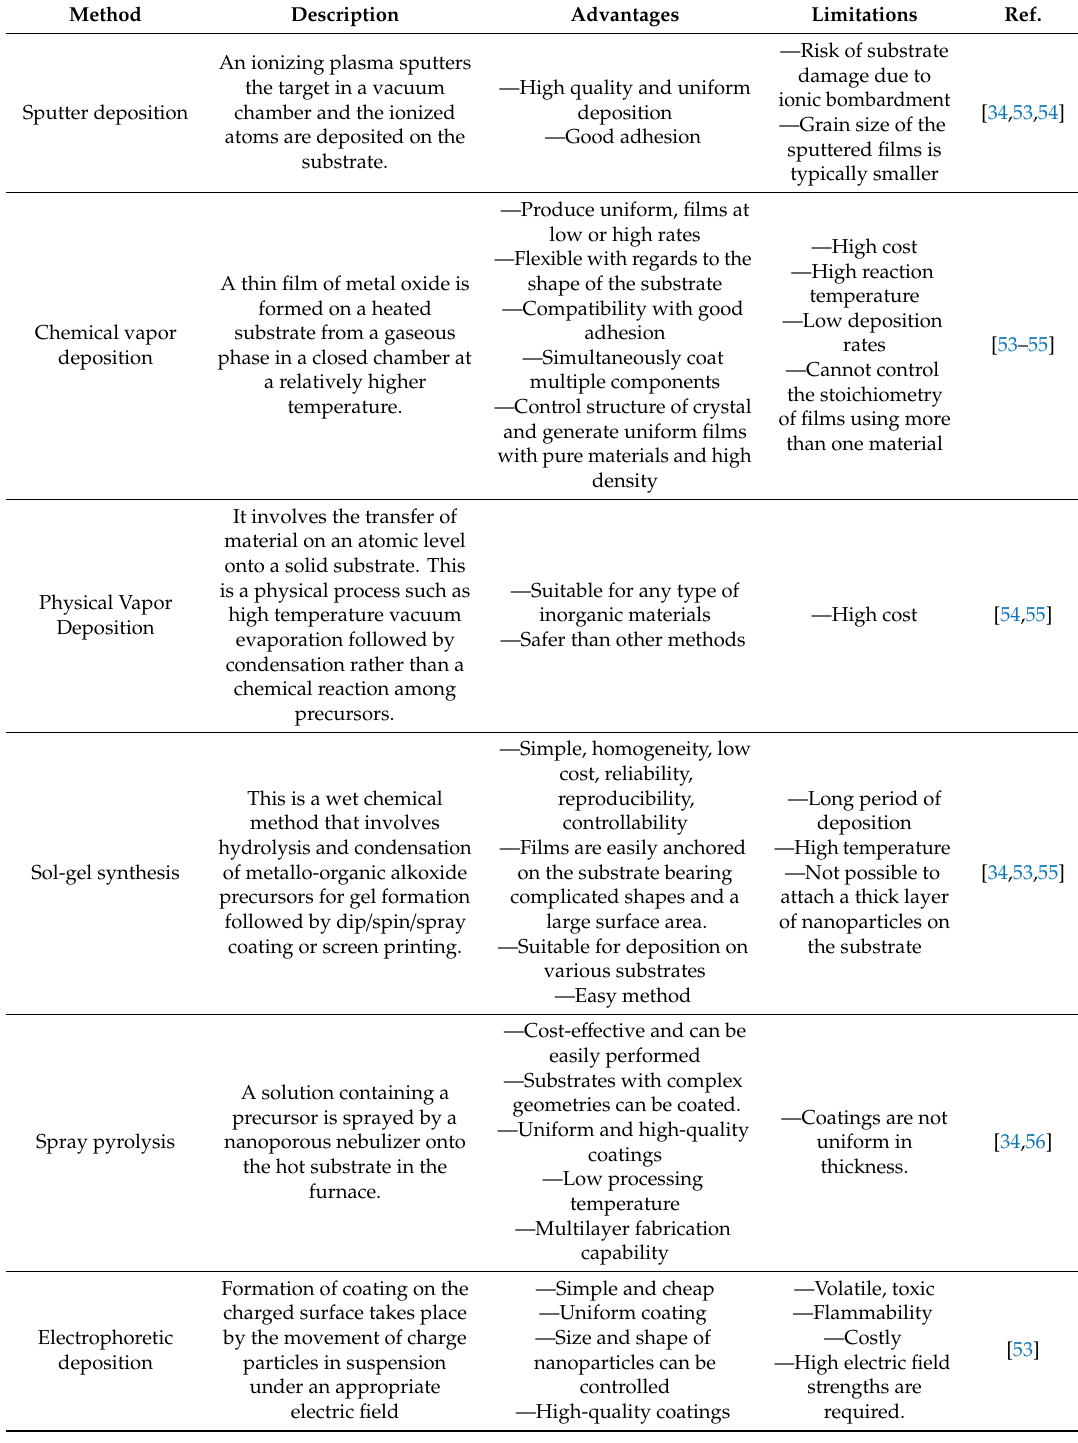
Table 1. Common techniques for TiO 2 coating and their advantages as well as